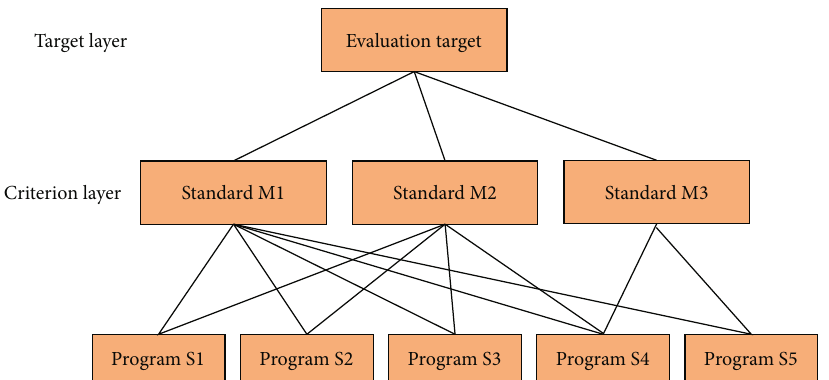
Figure 3: Analytic hierarchy process.